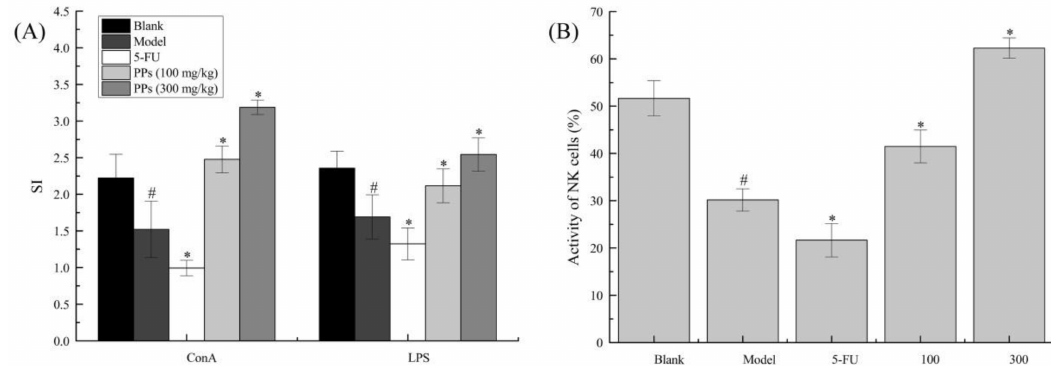
Figure 4. Effect of PPs on ConA- and LPS-induced splenic lymphocyte proliferation ( A ) and the activity of NK cells ( B ) in S180-bearing mice. # p < 0.05 compared to blank group was considered as significant; * p < 0.05 compared to model group was considered as